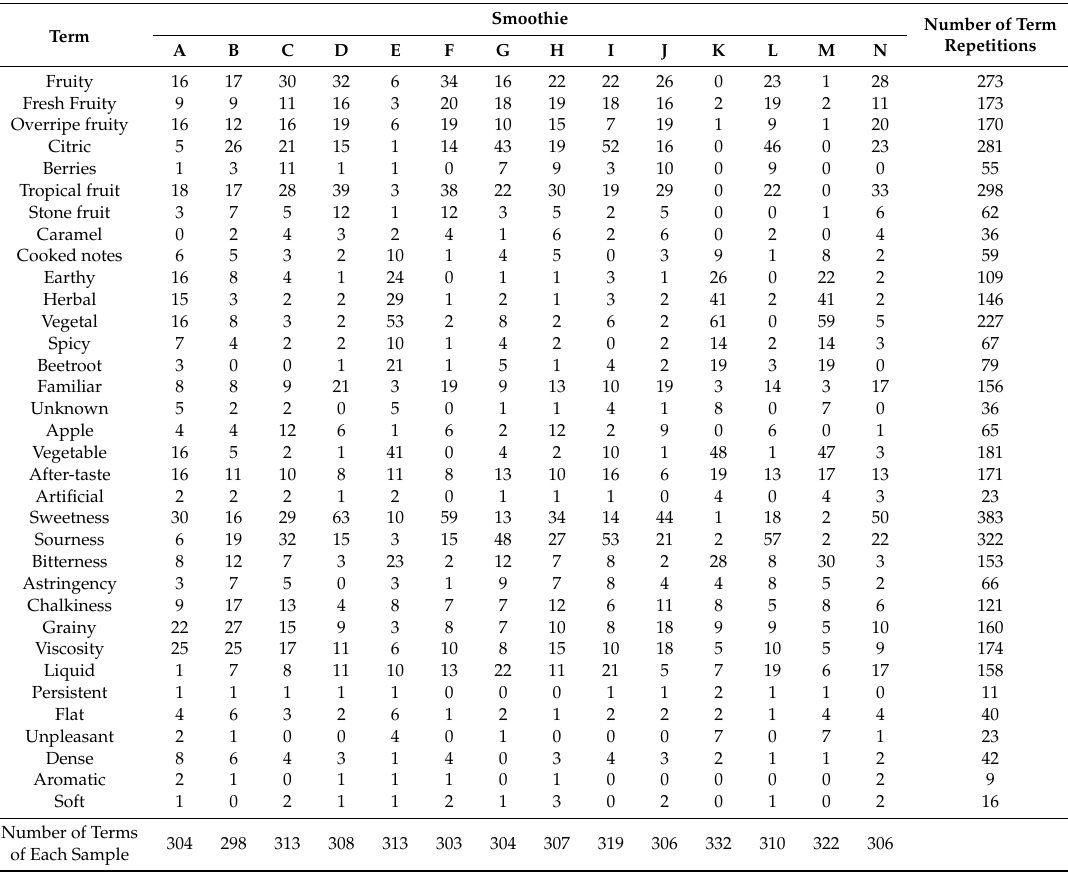
test and number of mentions for each of the samples, considering that 100 consumers participated in the